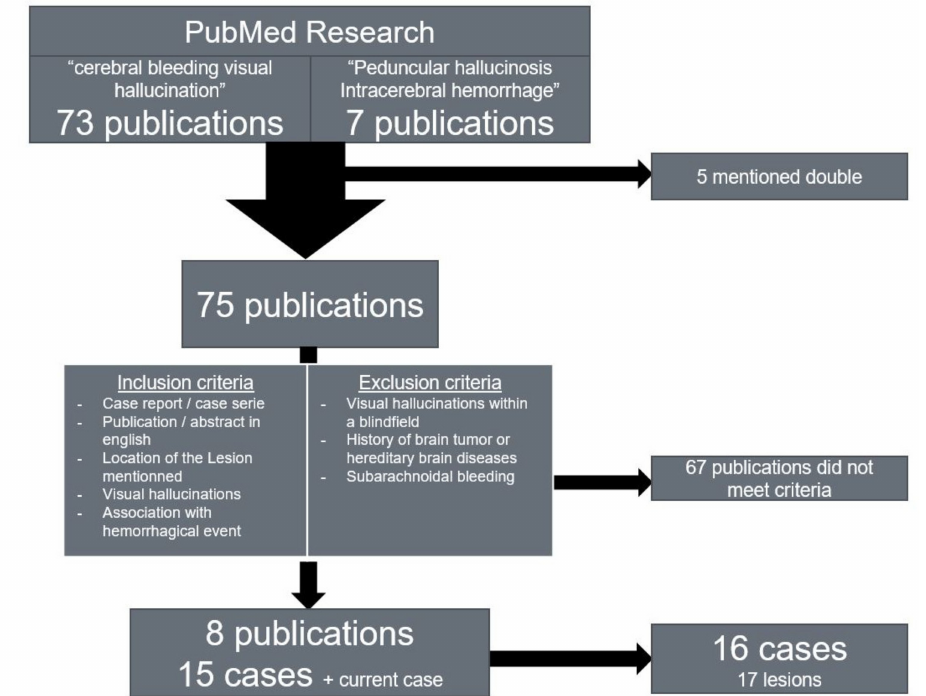
Figure 2. Pubmed research.